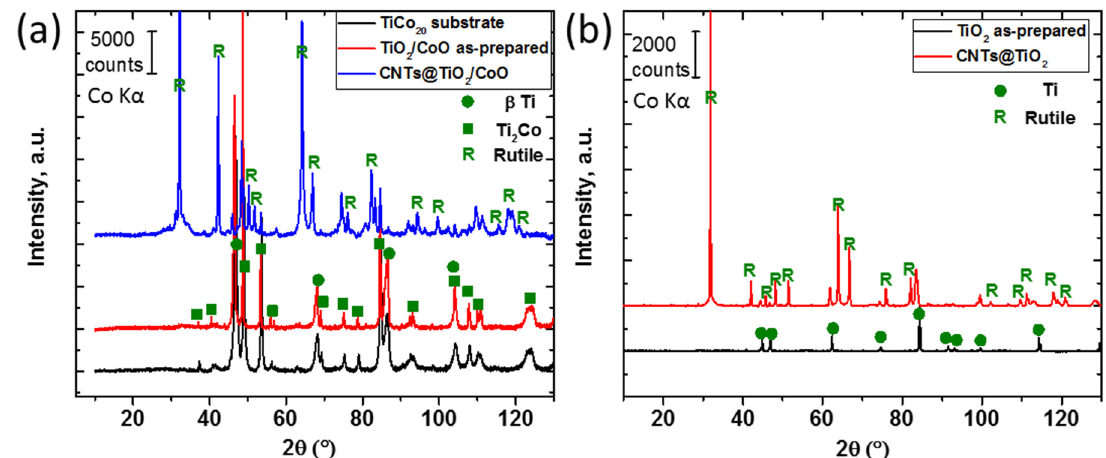
Figure 3. XRD patterns of the Ti 80 Co 20 alloy substrate, the as-anodized TiO 2 /CoO NTs, and the as-prepared CNTs@TiO 2 /CoO NTs ( a ); diffractograms of the as-anodized TiO 2 and CNT@TiO 2 NTs samples ( b ).